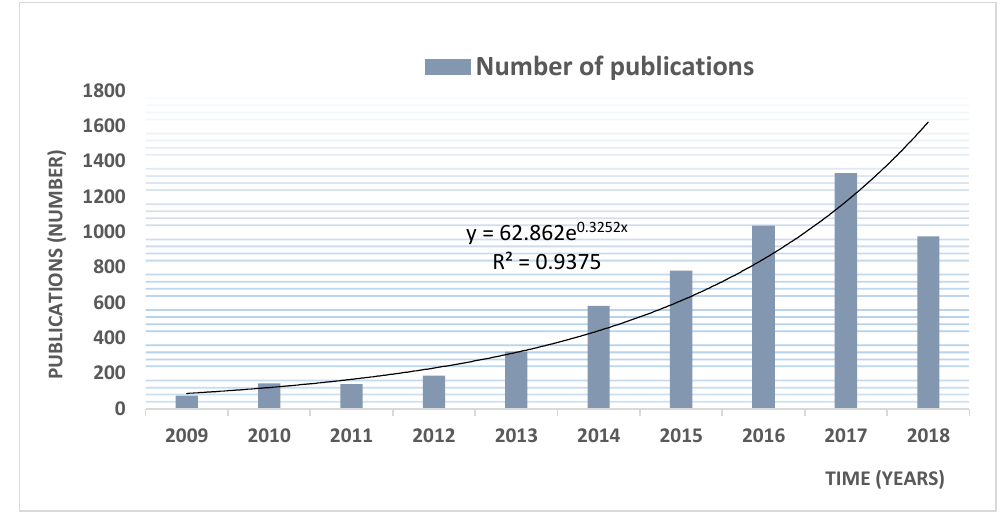
Figure 1. Trend of number of publications, 2009 – 2018. Note: 2018 is incomplete and has data only for July months.